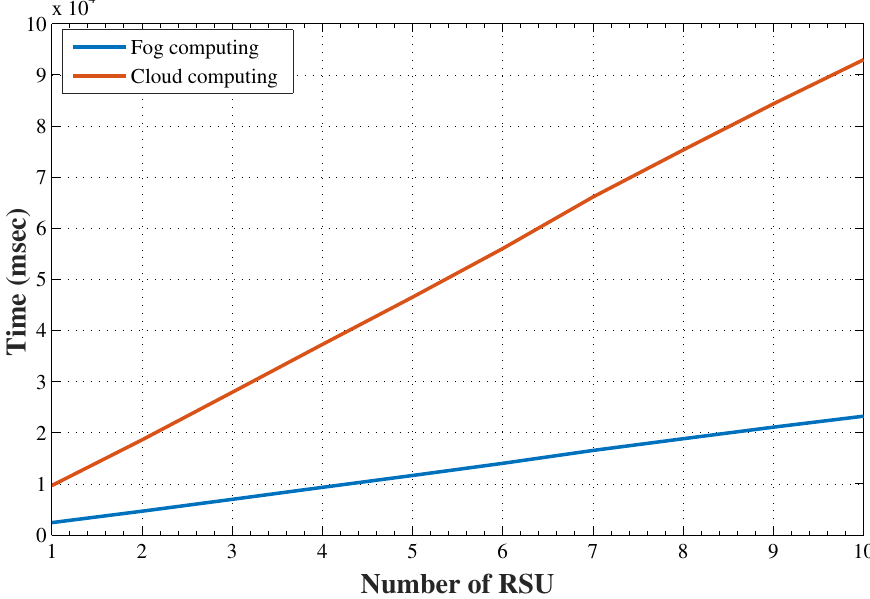
Figure 2. Task execution time in fog and cloud servers for varying number of